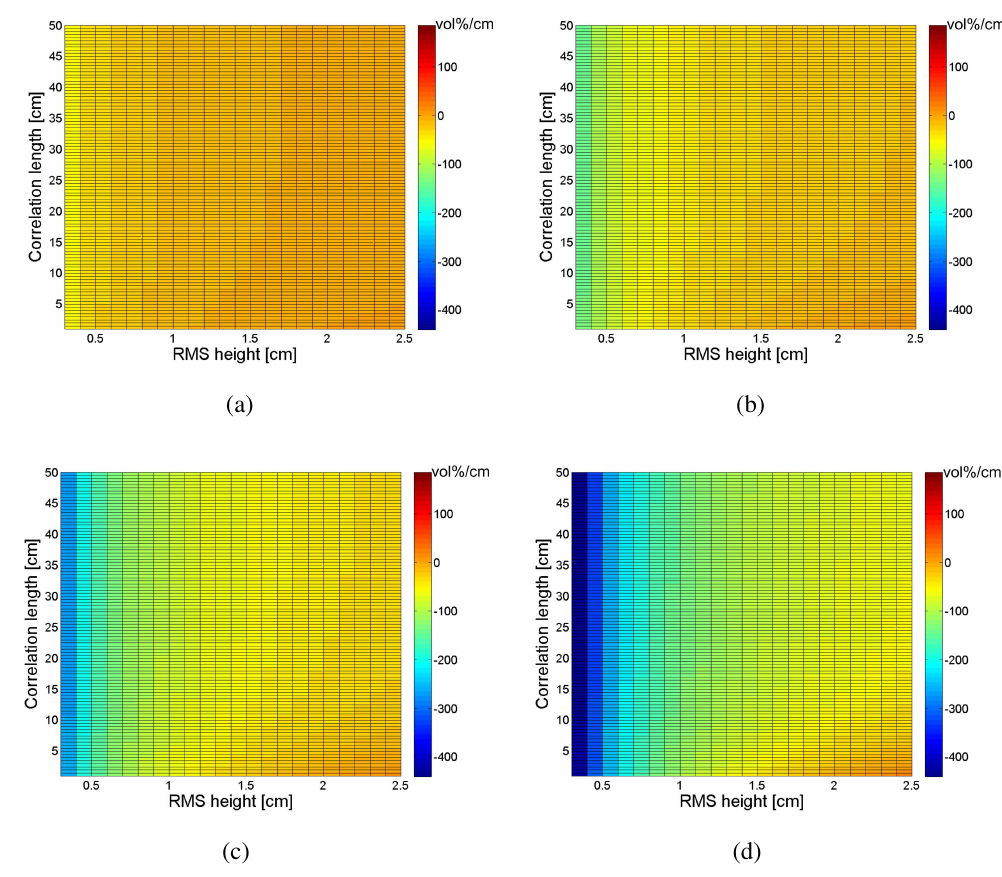
Figure 4. Sensitivity of the soil moisture retrieval to RMS height (vol%/cm) for a PALSAR HH configuration and a moisture content of (a) 5 vol%, (b) 15 vol%, (c) 25 vol%, and (d) 35